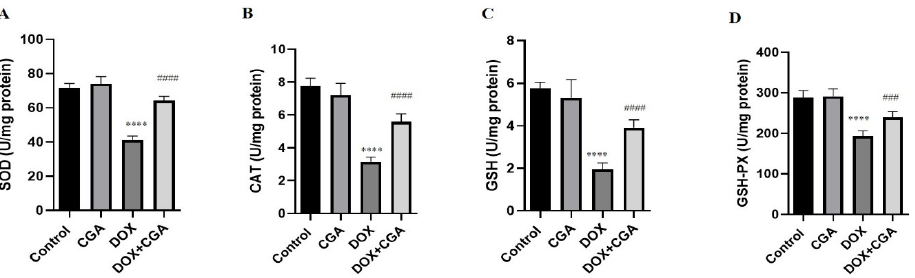
Figure 5. Oxidative stress markers in cardiac tissue. CGA signi fi cantly reversed the DOX-related oxidative stress via the elevation of ( A ) SOD, ( B ) CAT, ( C ) GSH-PX, and ( D ) GSH levels. Data are presented as the means ± SD. **** p < 0.0001 vs. the control group, ### p < 0.001, #### p < 0.0001 vs. the DOX group (n = 7). CGA: Chlorogenic acid (100 mg/kg); DOX: Doxorubicin (15 mg/kg); SOD: